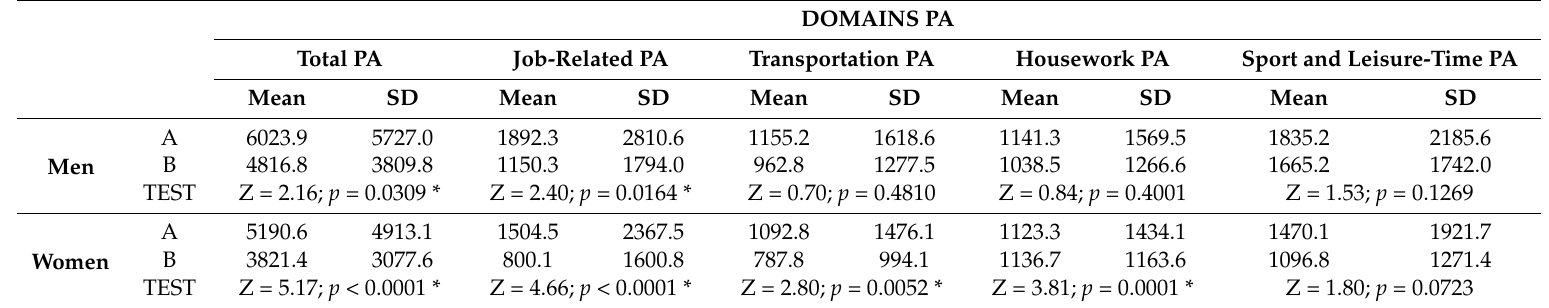
Table 3. Level of total activity and its domains by gender in different countries (Met-min./week).